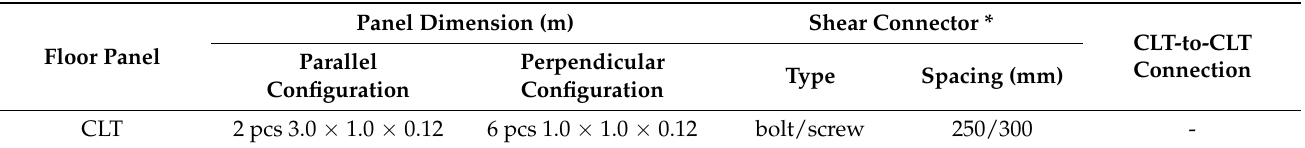
Table 11. Natural frequency (flexural mode) and damping ratio of various STC floors measured by Chiniforush et al. [47]. CLT panels with different shear connectors and configurations were tested.